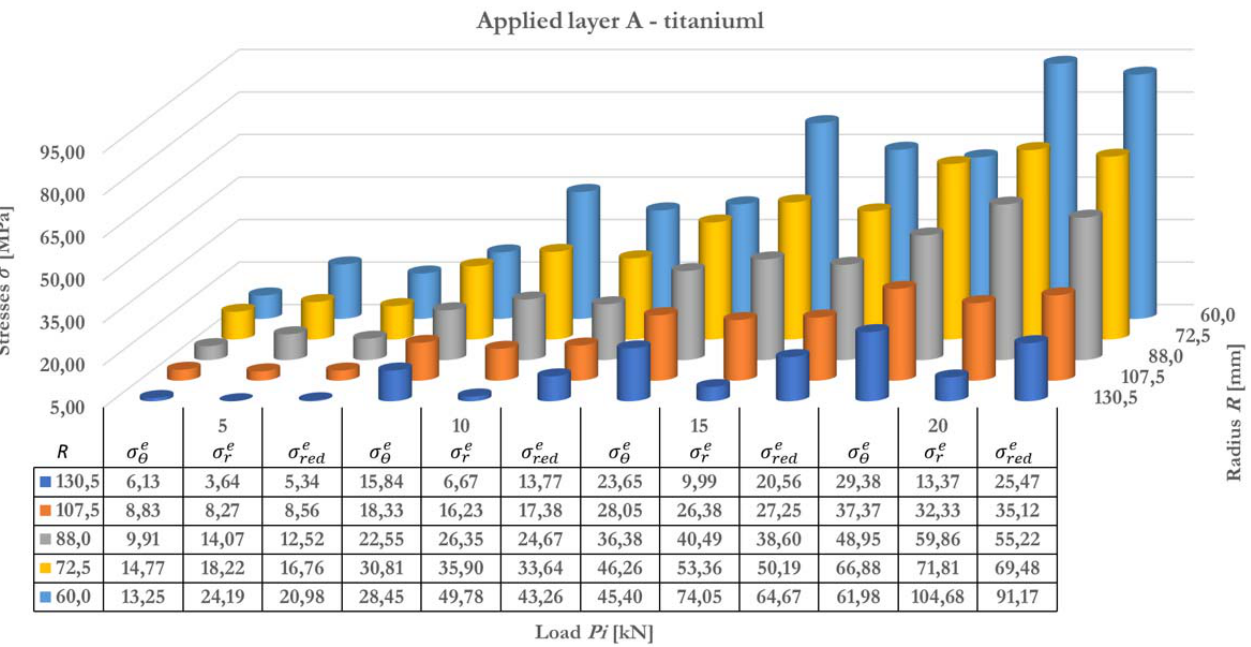
Figure 10: Summary of the stress values, respectively:   ,  r  red determined on the surface of the applied layer of the plate A – titanium, in this case, the load was applied from the side of the titanium layer.